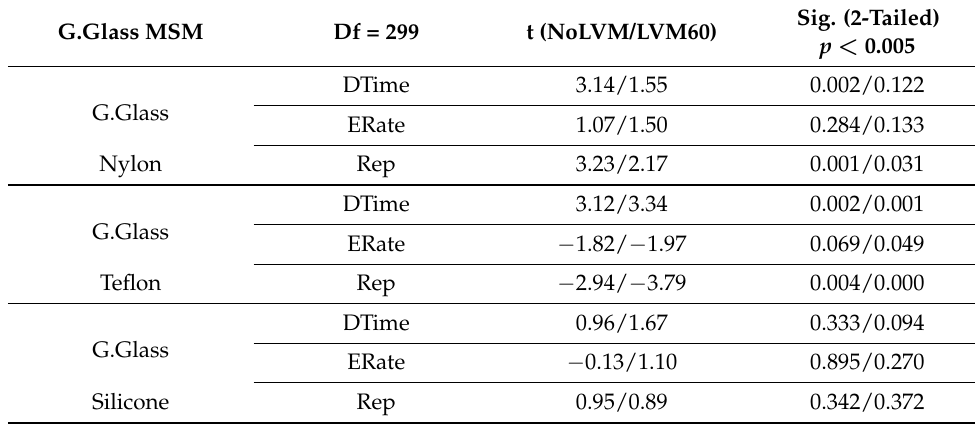
Table 1. Results of Repeated Measures Paired Samples t